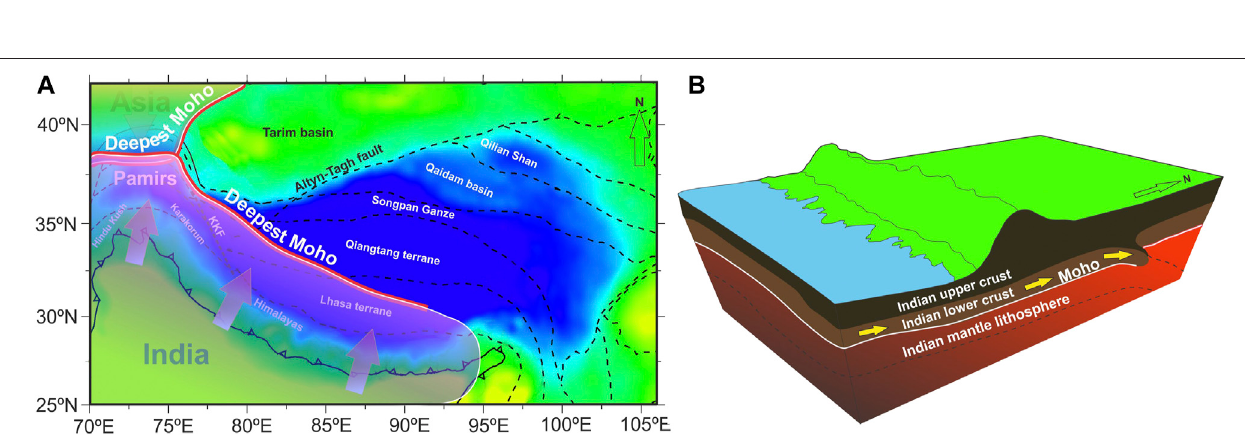
Frontiers in Earth Science |